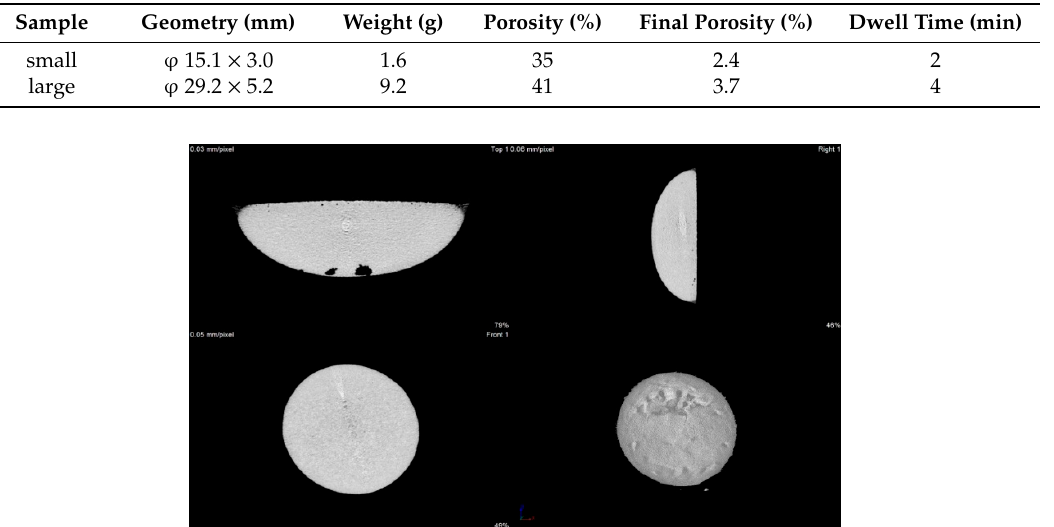
Table 1. Geometry, porosity and final porosity of the investigated titanium samples.